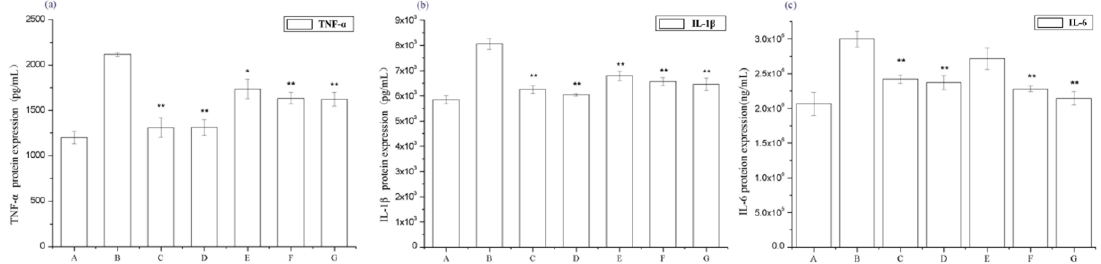
Figure 4. Effects of periostracum cicadae on the serum levels of tumor necrosis factor-α (TNF-α), interleukin-1β (IL-1β), and interleukin 6 (IL-6) in IgAN rats (* p < 0.05, ** p < 0.01). A: Healthy, normal control group; B: IgAN model group; C: prednisone acetate group; D: tripterygium glycoside tablet group; E–G: treatment group that received 0.5, 1, and 2 g/kg periostracum cicadae, respectively.